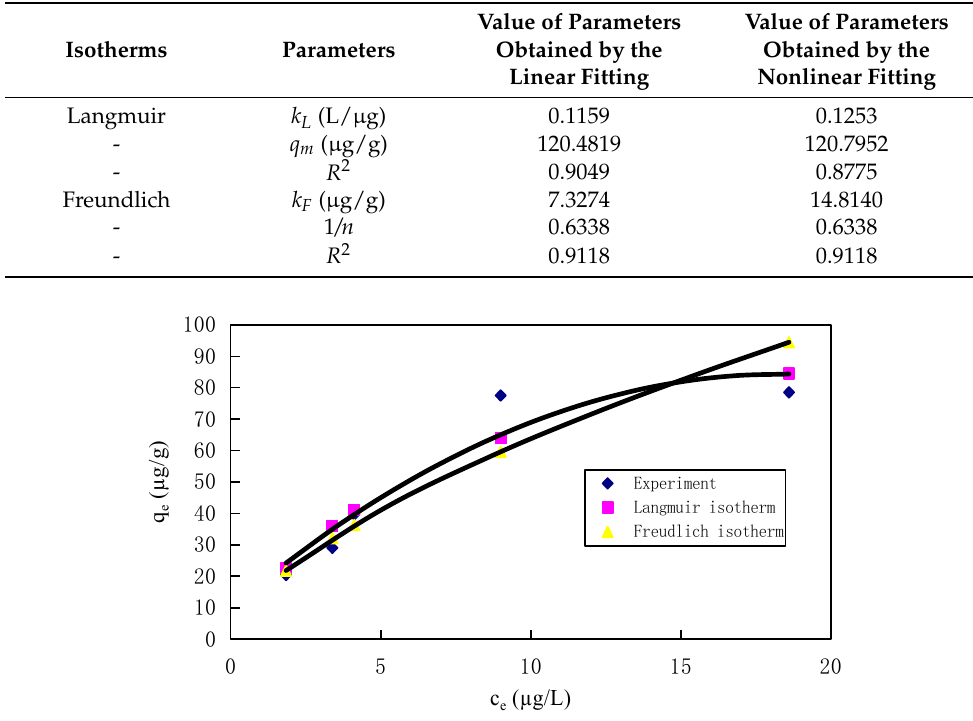
Figure 4. Experimental equilibrium data and isotherm obtained by the nonlinear regression method for the sorption of Hg ions on the Fe 3 O 4 /rGO composite (initial pH = 7.0, the Fe 3 O 4 /rGO composite dosage = 20 mg, temperature = 25 °C and contact time = 60 min). Table 2. The Langmuir and Freundlich isotherm parameters for the removal of the Hg ions by the Fe 3 O 4 /rGO composites.